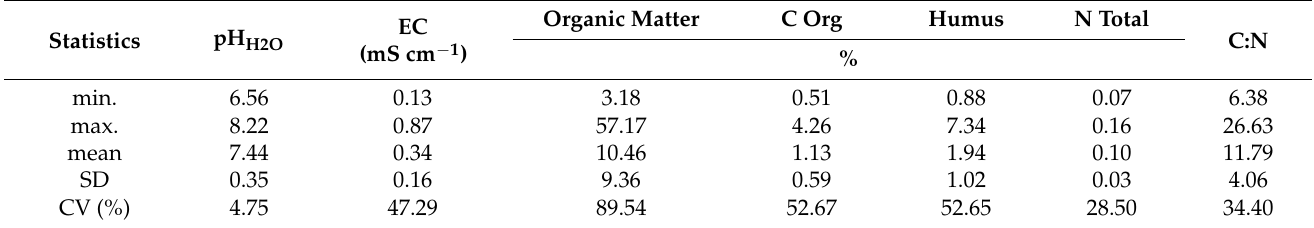
Table 3. Soil reaction, EC, content of organic matter, organic carbon, humus, total nitrogen, and the C:N ratio of 31 allotment plots in Gorz ó w Wielkopolski.